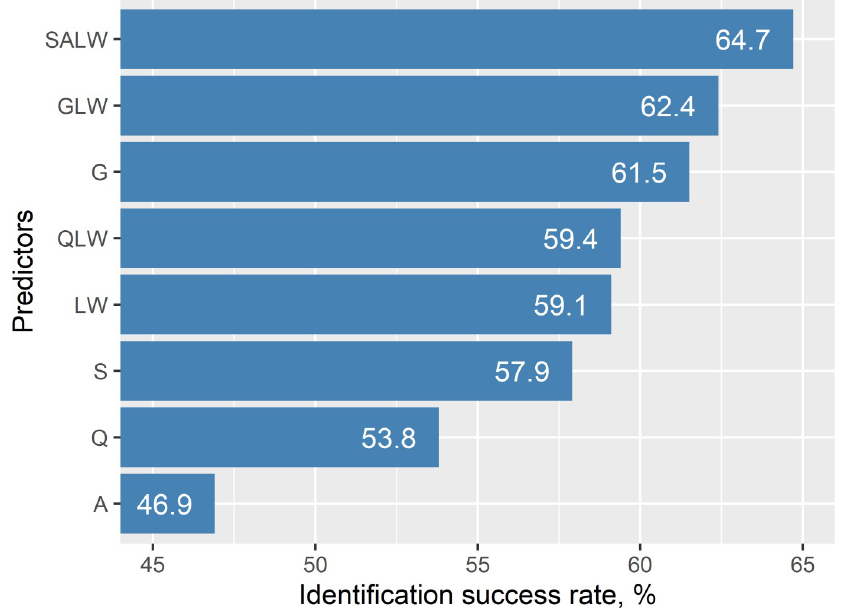
Fig 6. Discriminant models including both size and shape descriptors outperform those with either predictor type. For each value on y axis, species identification success rate from discriminant analysis is displayed as an average value from 1000 replicates of cross-validation. Abbreviations on y axis: S = symmetric shape variation (first principal component), A = asymmetric shape variation (three first principal components), G = global shape variation (two first principal components), LW = length + width, Q = length to width ratio, QLW = length to width ratio + length + width, GLW = global shape variation + length + width, SALW = symmetric shape variation + asymmetric shape variation + length +